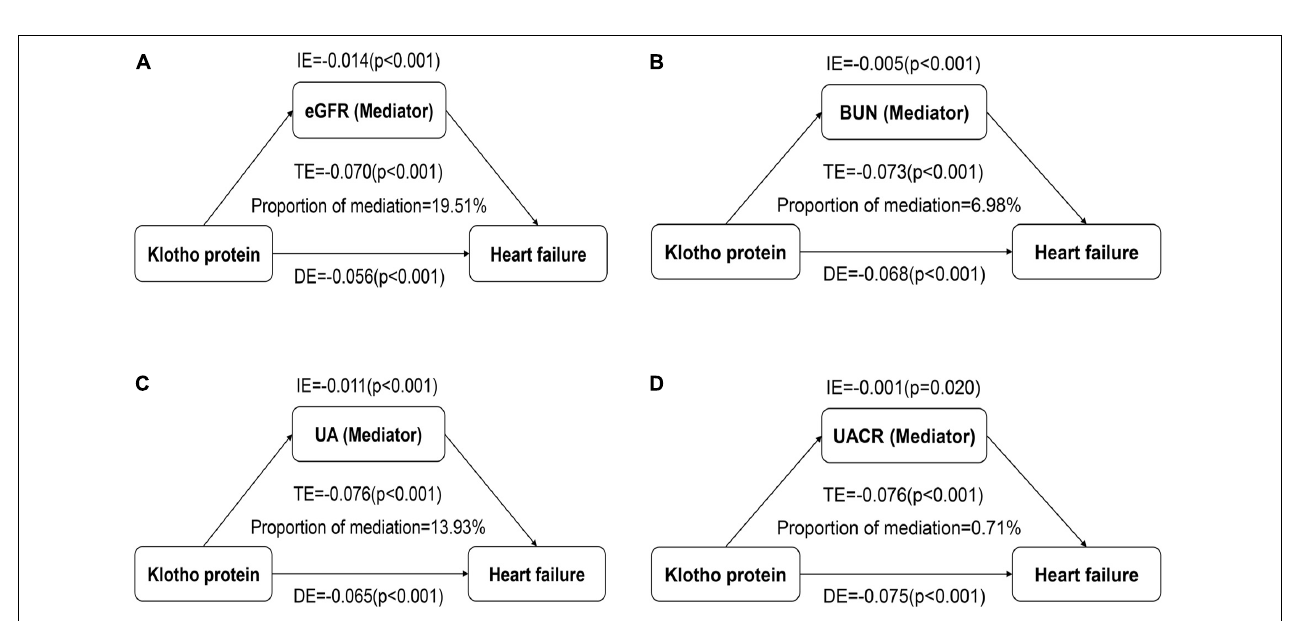
FIGURE 2 | Effect of the renal function markers (mediators) on the relationship between Klotho (exposure) and congestive heart failure (CHF; outcome). (A) Mediation analysis for indirect effect of estimated glomerular filtration rate (eGFR); (B) Mediation analysis for indirect effect of blood urea nitrogen (BUN); (C) Mediation analysis for indirect effect of uric acid (UA); (D) Mediation analysis for indirect effect of urine albumin-to-creatinine ratio (UACR). DE, direct effect; IE, indirect effect; TE, total effect.